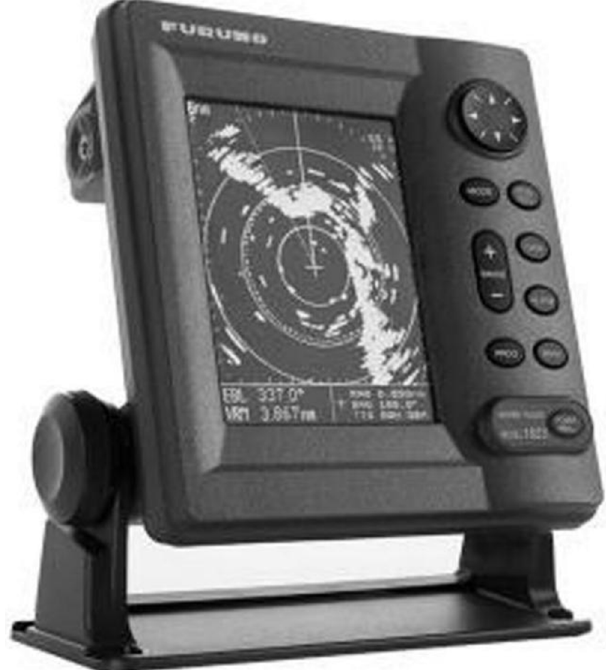
Fig. 2. Radar antenna of FURUNO.